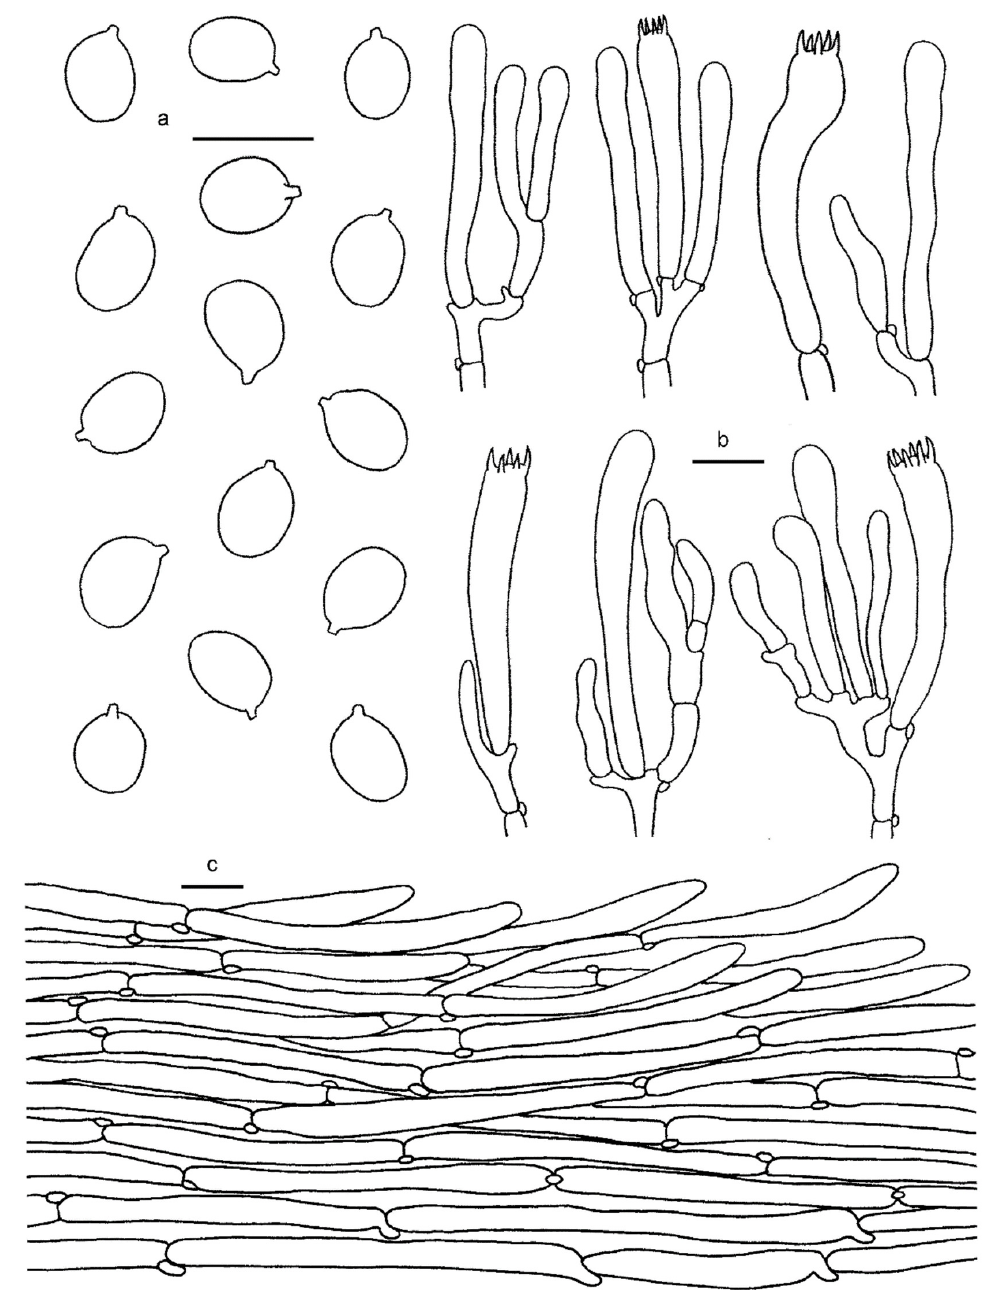
Figure 9. Cantharellus citrinus . ( a ) Basidiospores. ( b ) Basidia, basidiola and elements of the subhymenium. ( c ) Pileipellis. Bars: ( a , b ) = 10 μ m; ( c ) = 20 μ m. Basidiospores 7–9 × 5–6(6.5) μ m, L m × W m = 7.77(±0.47) × 5.29(±0.40) μ m, Q = (1.17)1.23–1.6(1.64), Q m = 1.47 ± 0.11; broadly elliptical to subglobose, smooth, guttulate, thin-walled. Basidia 55–65 × 7–8 μ m, 4–6-spored, narrowly clavate, colorless to hyaline in KOH; sterigmata 5–10 μ m long. Pileipellis a cutis with long, repent and occasionally in- terwoven hyphae, subcylindrical cells that are 5–15 μ m wide, thin-walled. Stipitipellis a cutis of cylindrical, parallel hyphae, 5–10 μ m wide. Clamp connections abundant in all tissues.